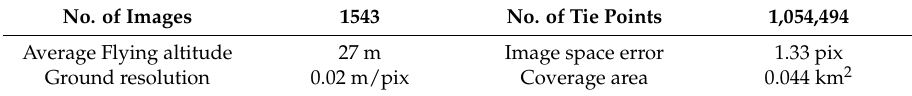
Figure 7. A perspective view of the constructed sparse point cloud. The blue dots over the sparse points show the camera’s position during the image acquisition by the UAV. Table 2. Structure from motion (SfM) results using all the captured images over a period of one year.